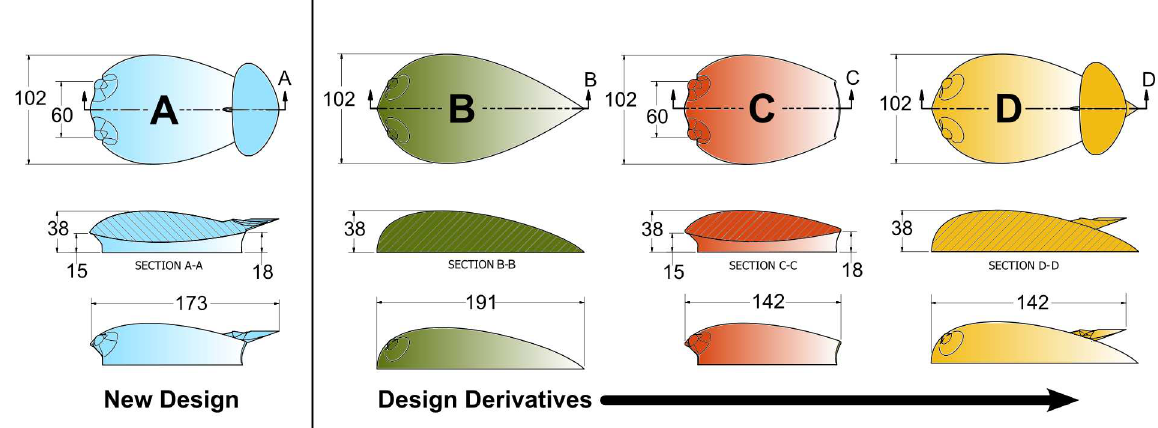
Fig 2. Tag housing designs in planform view (top row), longitudinal cross-section (middle row) and side view (bottom row). The longitudinal cross-sectionsare taken along the center line of the tags (marked A to D in the top row). The Model A designhas a hydrodynamic body, channeland wing. Dimensionsare in